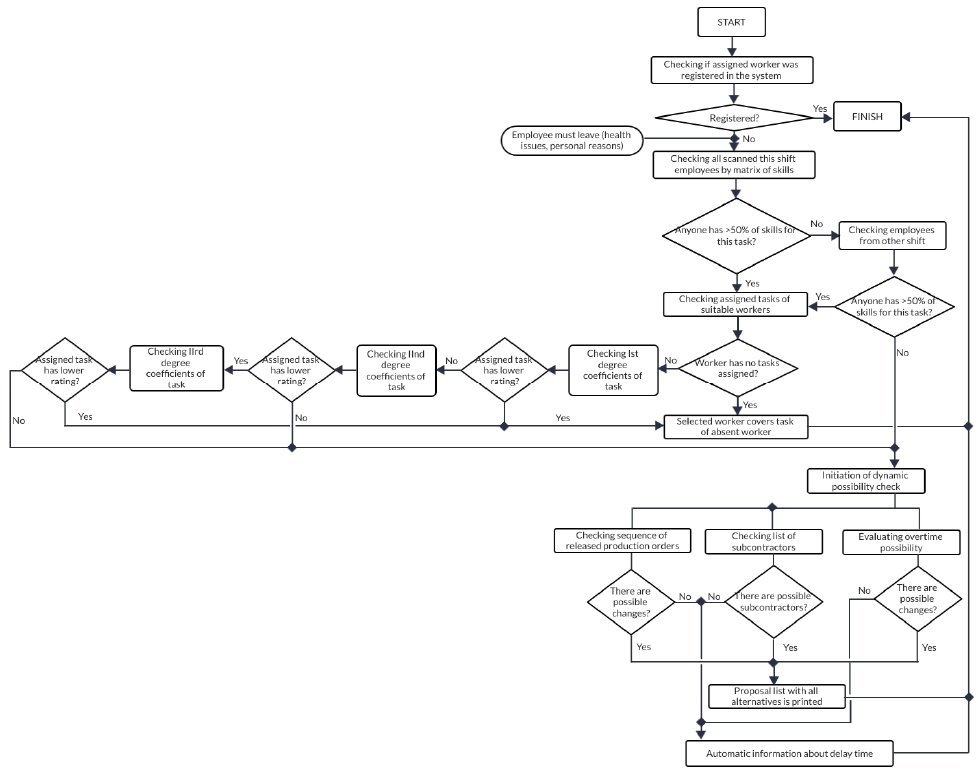
Figure 3. Workflow of presence of employees.